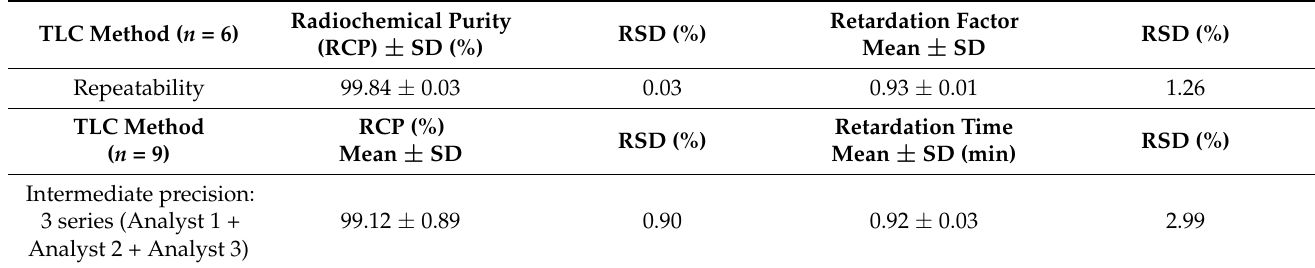
Table 6. Precision/repeatability and intermediate precision in TLC.